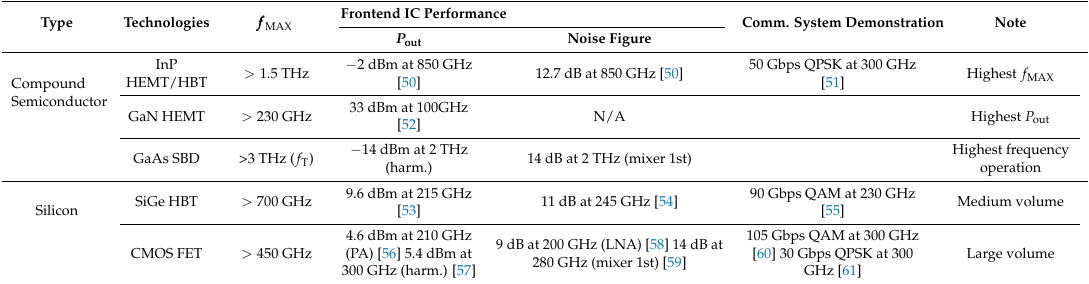
Table 1. Comparison of leading electronic terahertz front-ends and whole communication